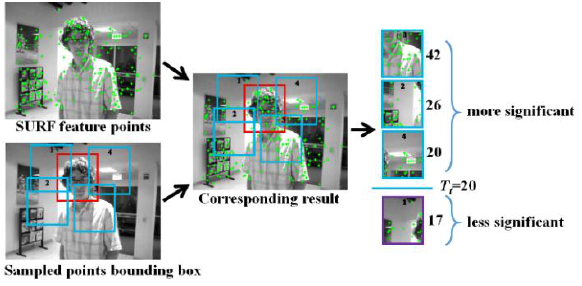
Figure 3. Overview of the SURF-based screening process.